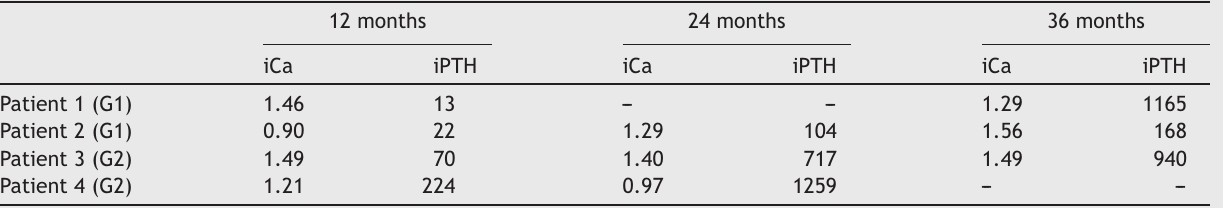
Graft-dependent recurrence in patients from G1 (2/66) --- conventional technique, and from G2 (2/52) ---